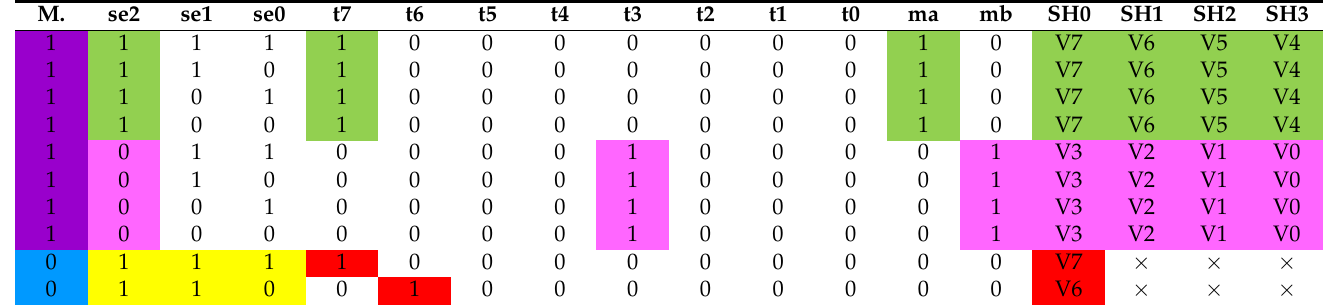
Table 1. Control signals of the 8-way switch control